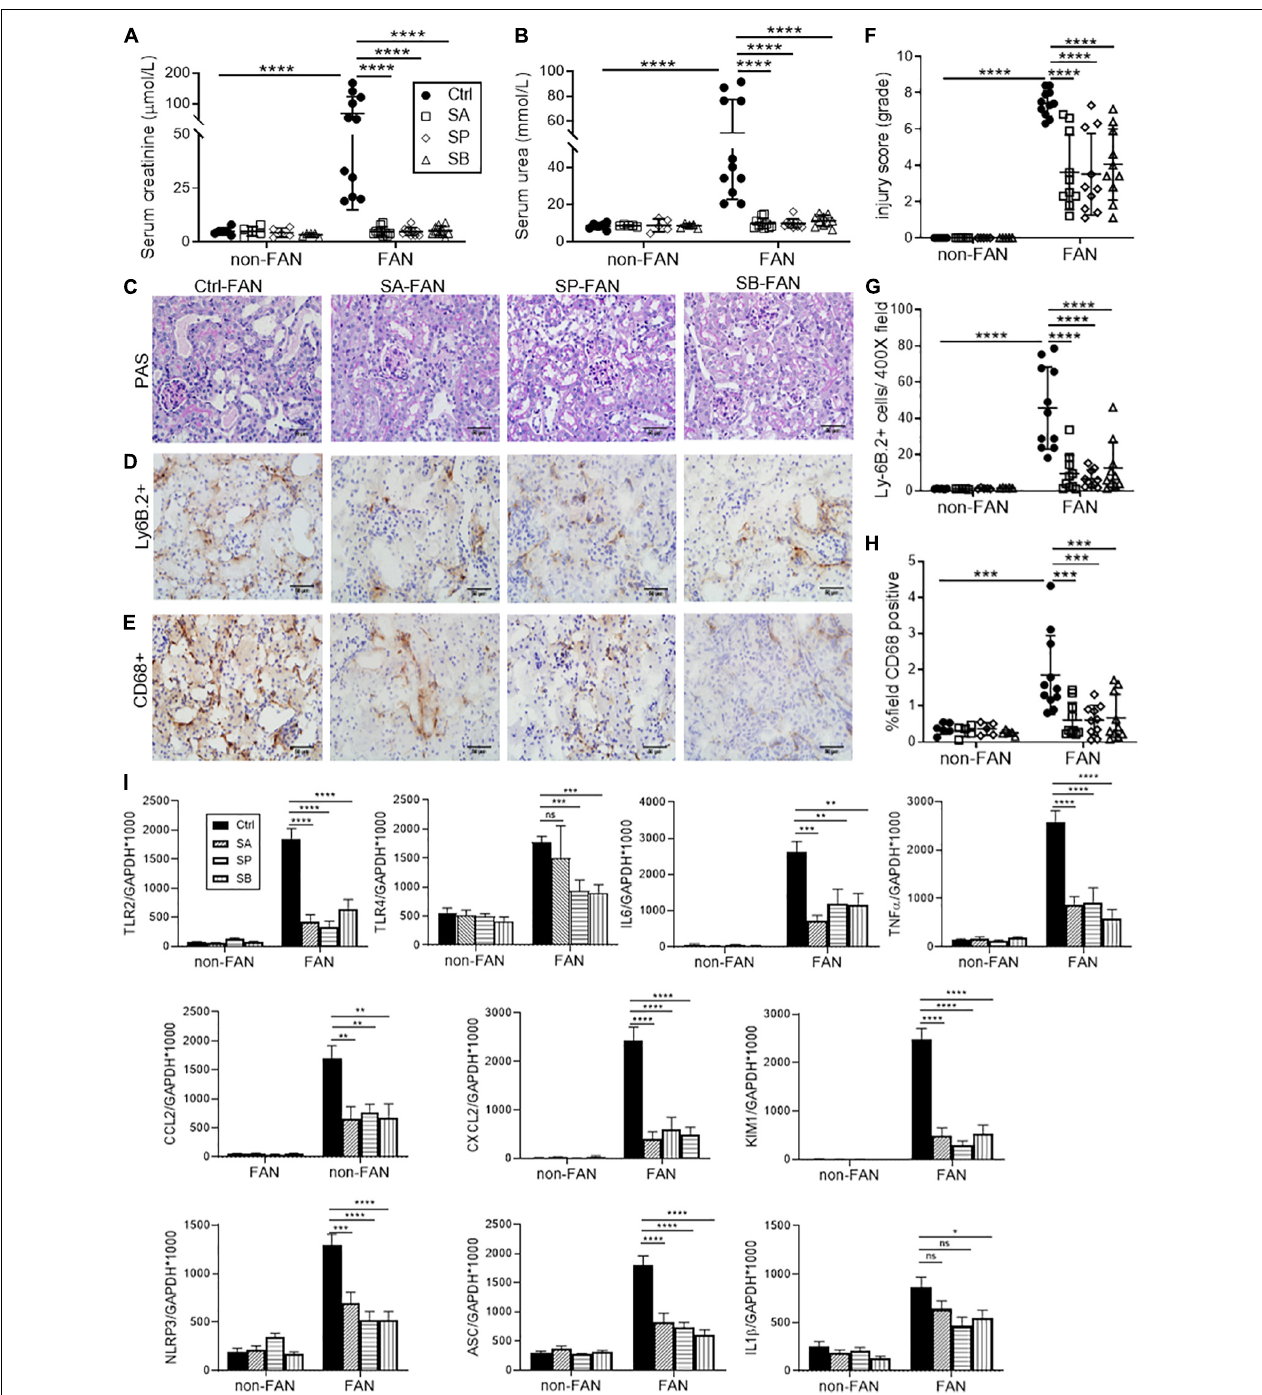
FIGURE 5 | SCFA supplementation attenuates AKI and inflammatory cell infiltrates at day 2. Treatment with SCFAs acetate (SA), butyrate (SB) or propionate (SP) protected against AKI in FAN with lower serum creatinine (A) , BUN (B) and tubular injury scores (F) . Histopathological assessment of PAS stained kidney sections (C) , demonstrated protection against kidney damage for all SCFA groups compared to control mice at day 2. Representative sections of immuno-stained kidney for Ly6B.2 + neutrophil (D) and CD68 + macrophages (E) demonstrate increased cell infiltrates following FAN induction in control mice, which was significantly diminished by SCFA treatment (G,H) . mRNA expression of innate immune receptors (TLR2 and TLR4), pro-inflammatory cytokines (IL6 and TNF α ), chemokines (CCL2 and CXCL2), inflammasome components (NLRP3, ASC and IL1 β ), and the proximal tubule injury marker (KIM1) was diminished by SCFA treatment, as measured by real-time PCR in kidney tissue (I) . FAN ( n = 10); non-FAN ( n = 5). Photomicrographs at 400 × , scale bar 50 µ m. Data are shown as means ± SD or mean ± SEM; * P < 0.05, ** P < 0.01, *** P < 0.001, **** P < 0.0001.